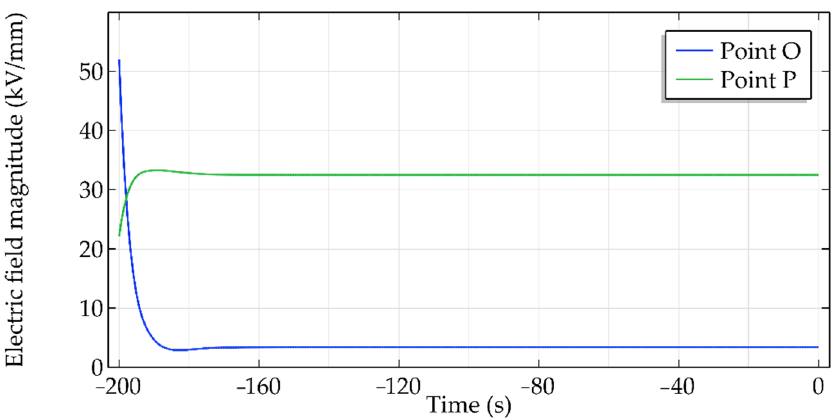
Figure 5. Electric field magnitude (kV/mm) in points 𝑂 and 𝑃 (Figure 1) as a function of time (s) in the 2nd case under applied 20 kV DC voltage.